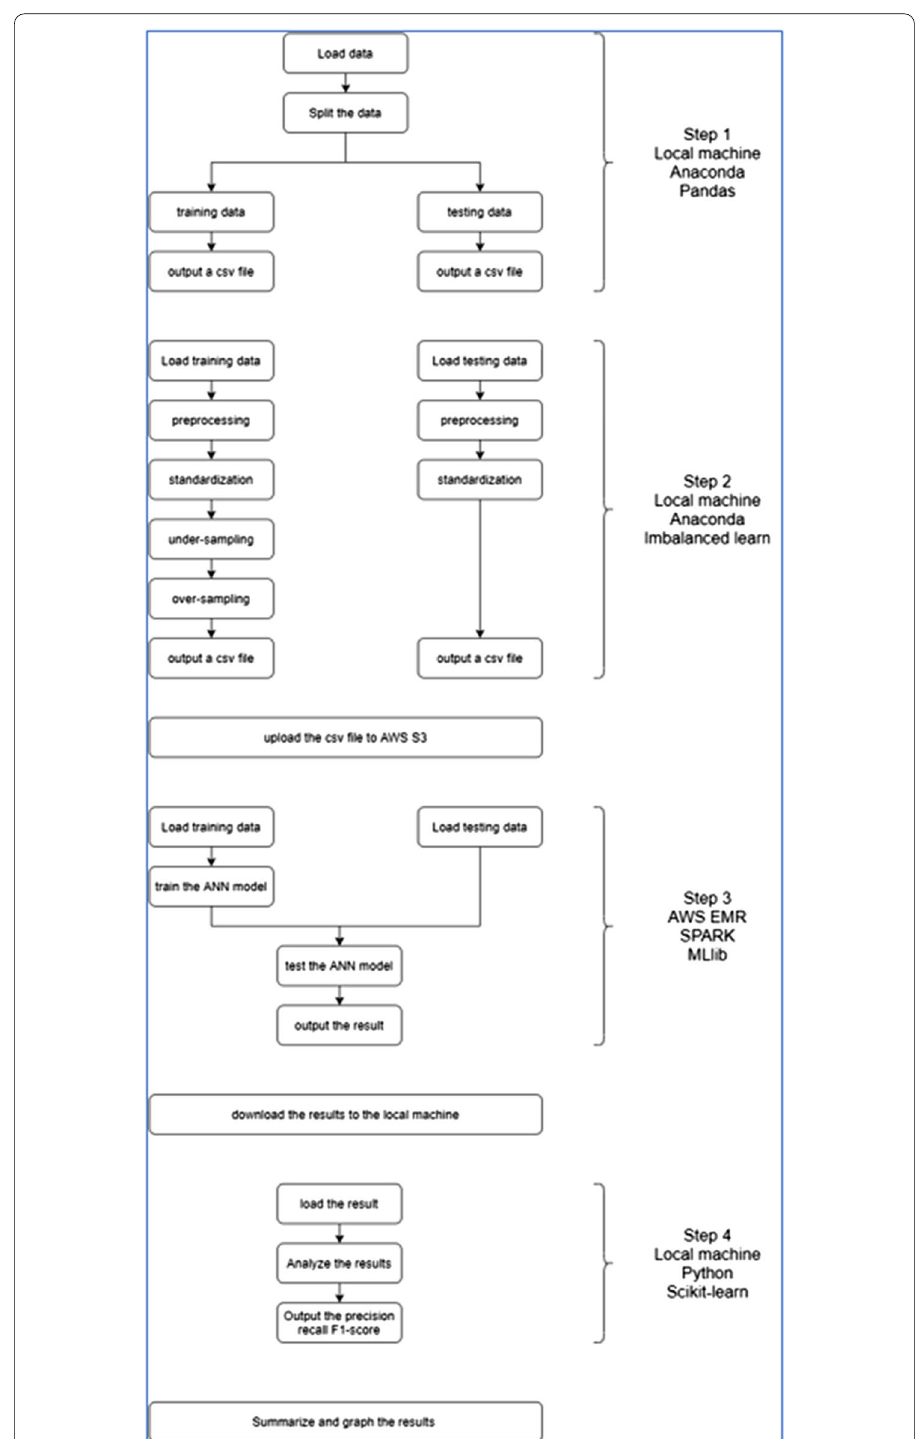
Fig. 1 Flow chart of the